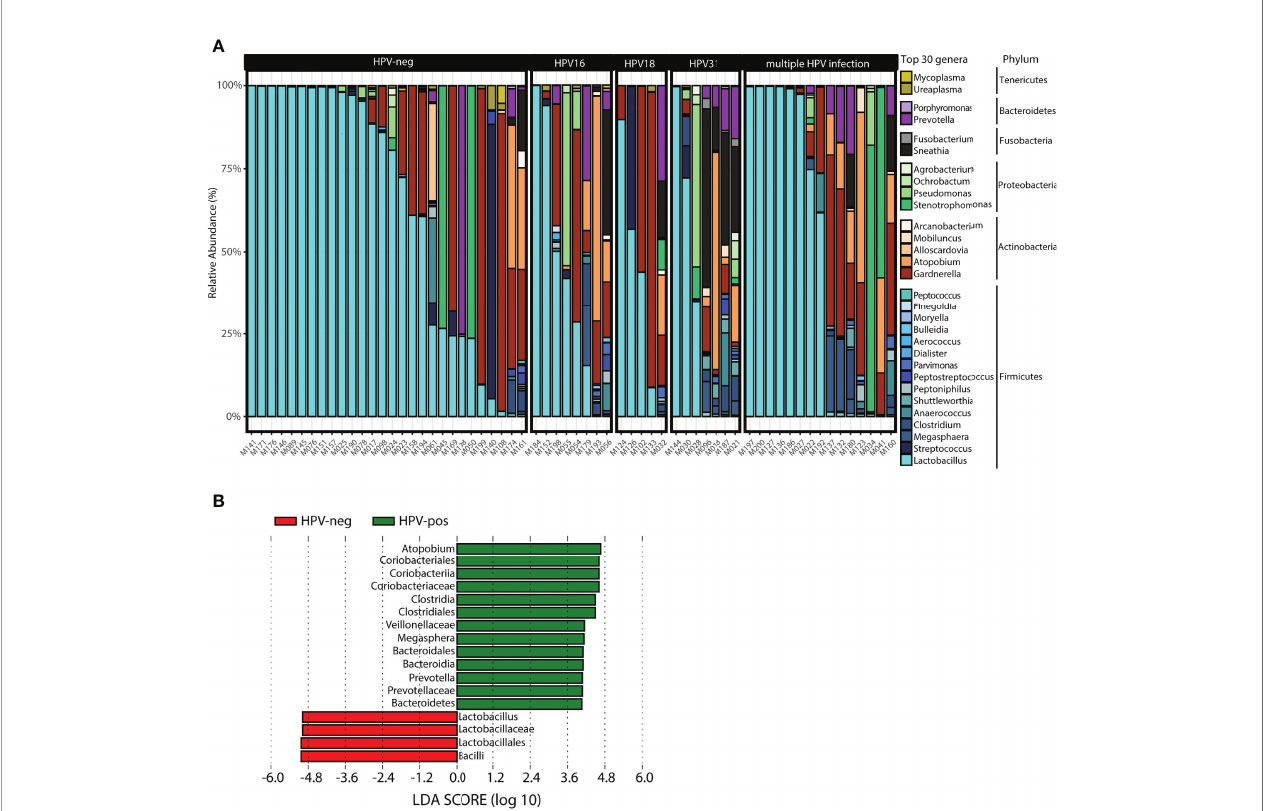
FIGURE 4 | Taxonomic pro fi le of the vaginal microbiota at genus level in women with symptomatic cervical ectopy. (A) Taxa barplots showing the taxonomic composition at genus level. The top 30 genera are represented, these account for 99.5% of all genera present. Genera are listed from the less abundant to the more abundant within each phylum, and ordered in ascending order (Tenericutes, Bacteroidetes, Fusobacteria, Proteobacteria, Actinobacteria, and Firmicutes). Color bars re fl ect the phyla they belong to and the intensity of the color their relative abundance, with light colors depicting the least abundant, and the darker colors the most abundant. (B) Histogram of the linear discriminant analysis scores reveals that 17 differential features were identi fi ed. Atopobium , Megasphaera , and Prevotella were found enriched in HPV-pos women while Lactobacillus was enriched in HPV-neg. Linear discriminant analysis Effect Size (LEfSe) analysis was performed with LDA values of 3.0 or